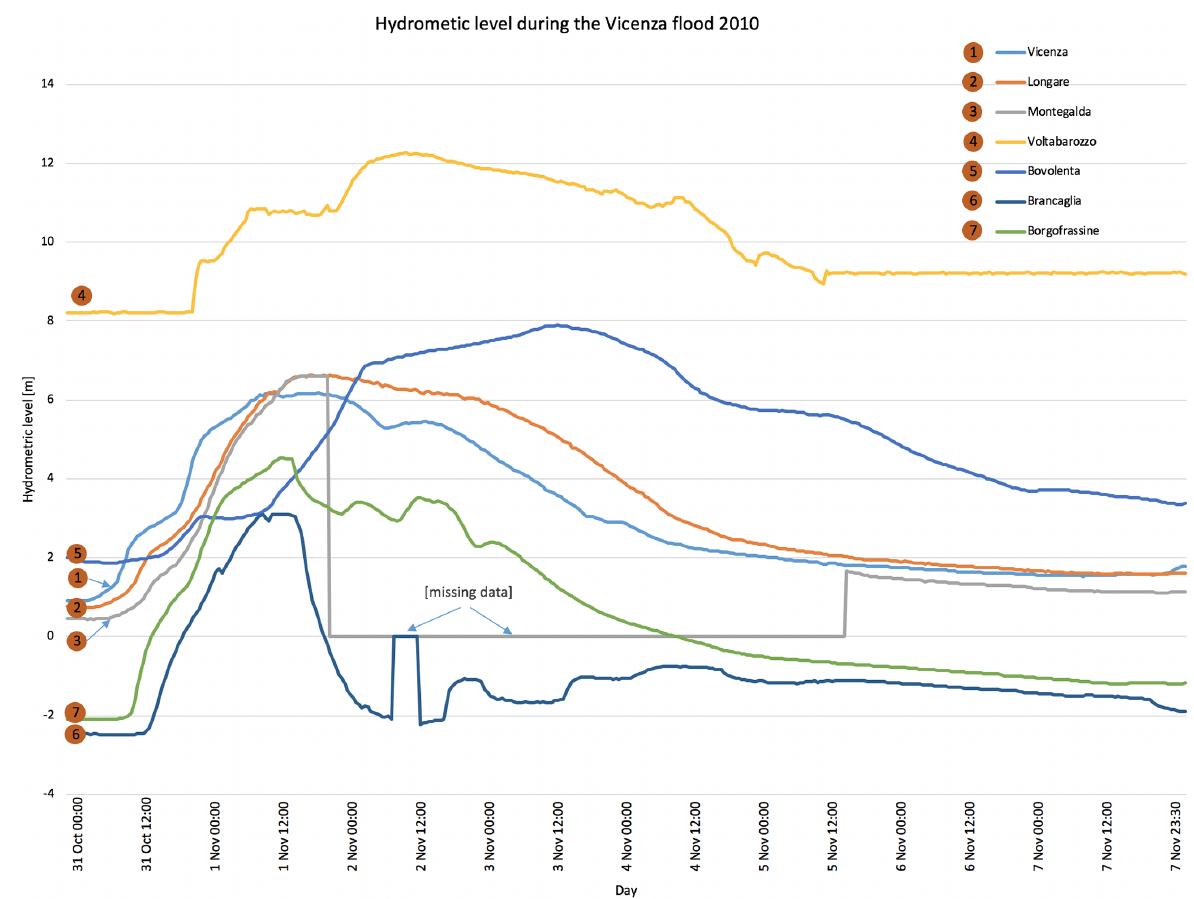
Figure 4. Measurements of hydrometers during the period of the investigated flood event. The flow of the Bacchiglione River (hydrometers 1 to 5) goes towards the southeast, i.e., from hydrometers 1 to 5. The flow of the Frassine River (hydrometers 6 and 7) goes towards the east, i.e., from hydrometers 6 to 7. In both cases, the measurements show the dynamic of the flood, which followed the stream of the